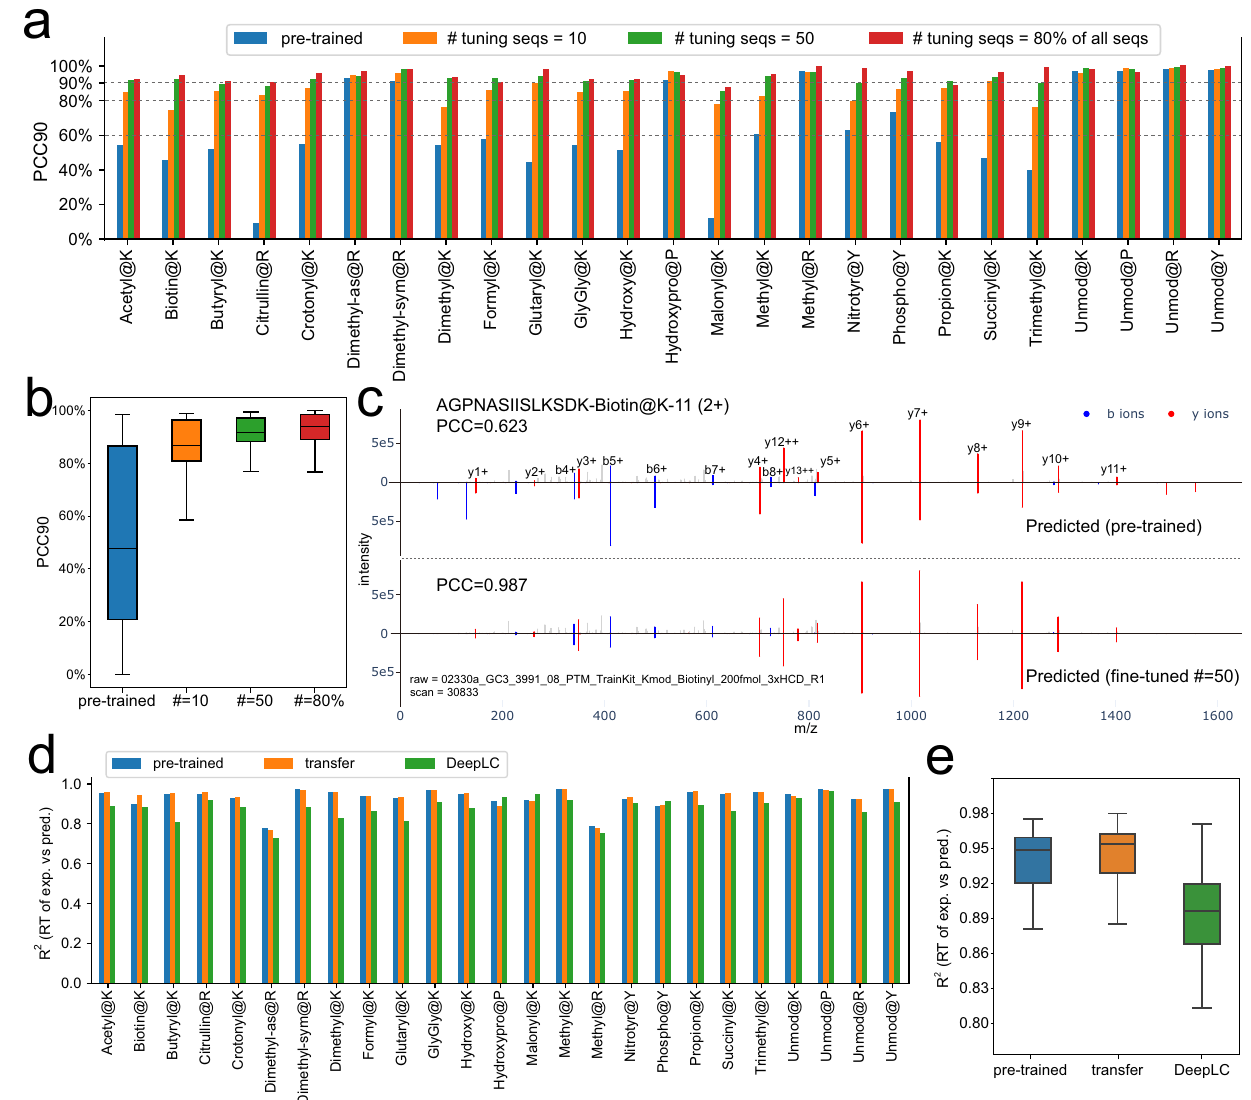
Fig. 4 | Model performance with transfer learning on 21 PTMs from Proteome Tools. a The accuracy of MS2 prediction with different numbers of peptides for transfer learning for each PTM. Each PTM is testedseparately. “ 80% seqs ” refersto using 80% of the identi fi ed modi fi ed sequences for transfer learning. b Overall accuracy without unmodi fi ed peptides from ( a ). Boxplots for n =21 PCC90 values of 21 PTM types are drawn with the interquartile range within the boxes and the median as a horizontal line. The whiskers extend to 1.5 times the size of the inter- quartilerange. c TransferlearningdramaticallyimprovestheMS2predictionofthe